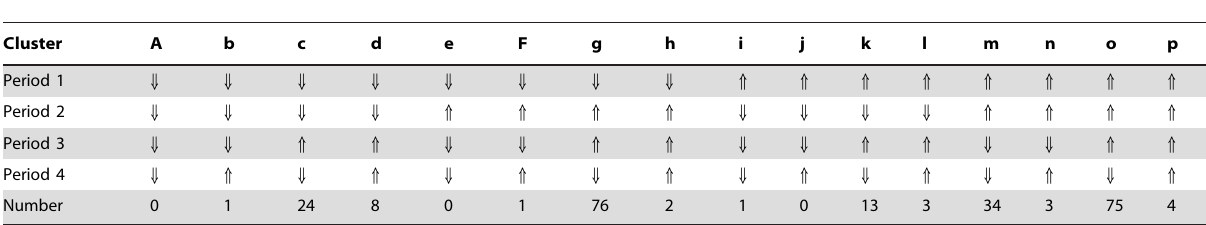
Table 2. Distribution of waveforms into the initial 16